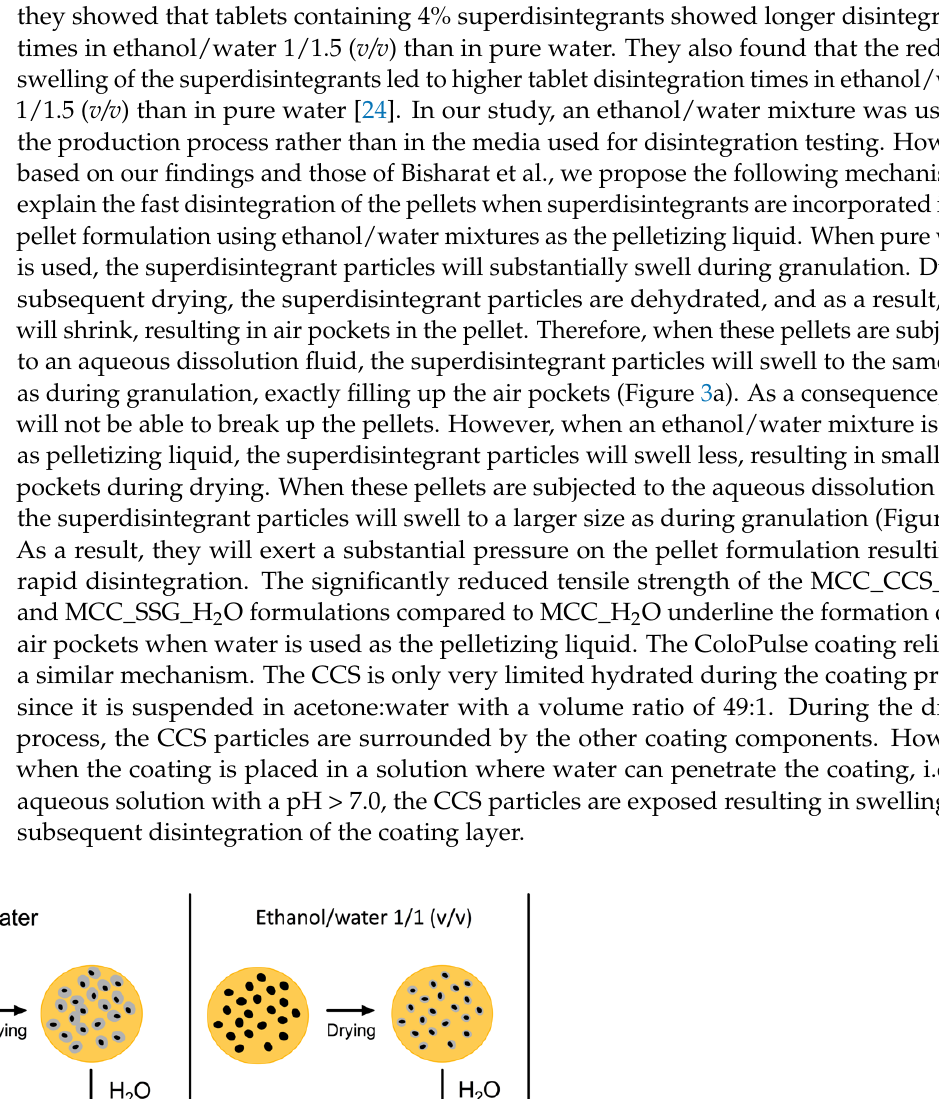
Figure 2. Swelling behavior of CCS and SSG in water and ethanol/water 1/1 ( v/v ). ( a ) CCS in ethanol/water 1/1 ( v/v ); ( b ) SSG in ethanol/water 1/1 ( v/v ); ( c ) CCS in water; ( d ) SSG in water.